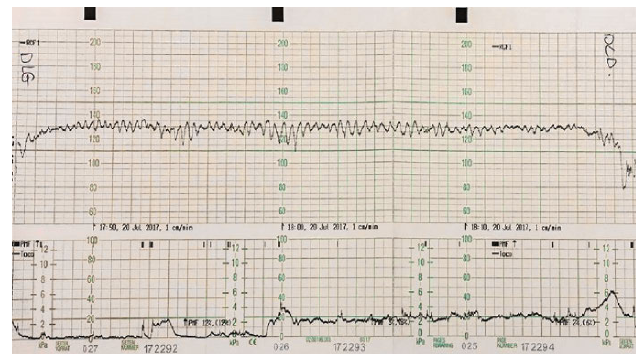
Figure 1 Results: A 28-years-old, nulliparous, A+ woman was seen at 38 gestational weeks (GW) for an ordinary obstetrical control. The pregnancy was normal except for fetal growth break at 36 GW and a maternal normochromic normocytic hyporegenerative anemia at the first trimester supplemented with iron. During this control, the mother reported decreased fetal movements for several days. A sinusoidal heart rate was observed which led to an emergency C-section (fig. 1). A 2830 g baby boy was delivered. He presented an extreme pallor, a hearth rate of > 100/ min, spontaneous respiration with oxygen support, hypotonicity and hyporeactivity. The APGAR score was 4/5/6 and the cord pH 7.17/7.22. Severe anemia was confirmed (cord Hb: